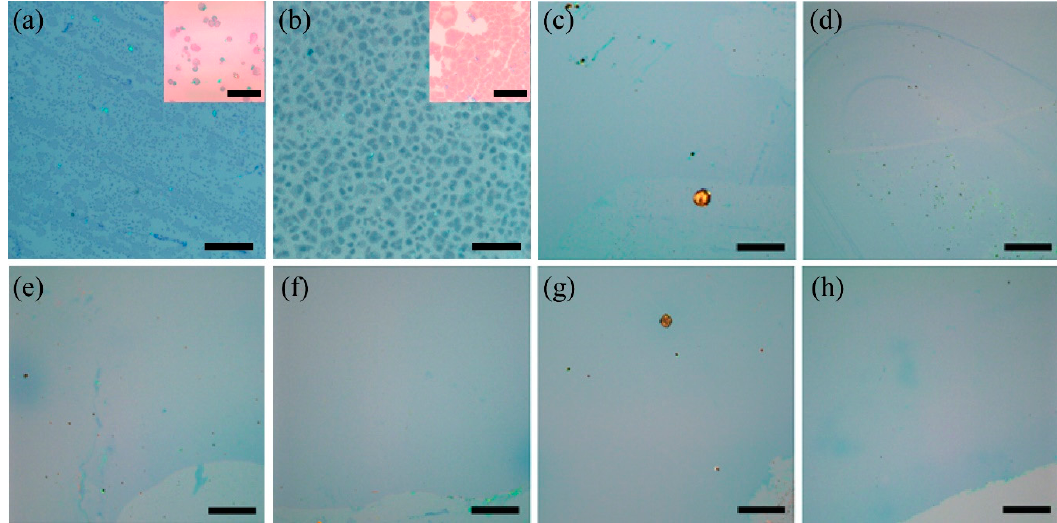
Figure 3. Optical images of the graphene that was directly grown on the 300 nm SiO 2 /Si substrate with respect to the growth durations of ( a – h ) 0.5, 2.5, 5, 10, 15, 20, 25, and 30 min. The scale bar in the inset respect to the growth durations of ( a–h ) 0.5, 2.5, 5, 10, 15, 20, 25, and 30 min. The scale bar in the inset image in ( a , b ) are 20 µ m, while the others are 200 µ image in ( a ) and ( b ) are 20 µm, while the others are 200 µm.